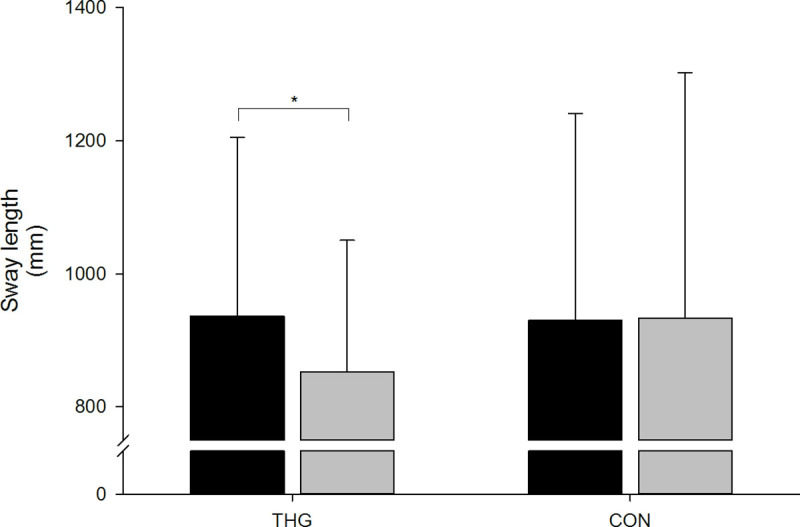
Postural balance.Postural balance assessed as center of pressure (CoP) sway length during 30-sek unilateral static balance test at baseline (black columns) and following (grey columns) 12 wks small-sided team handball training (THG) or no training (CON). Mean ± standard deviation (SD) are presented. *Within-group difference compared to baseline (p<0.05).